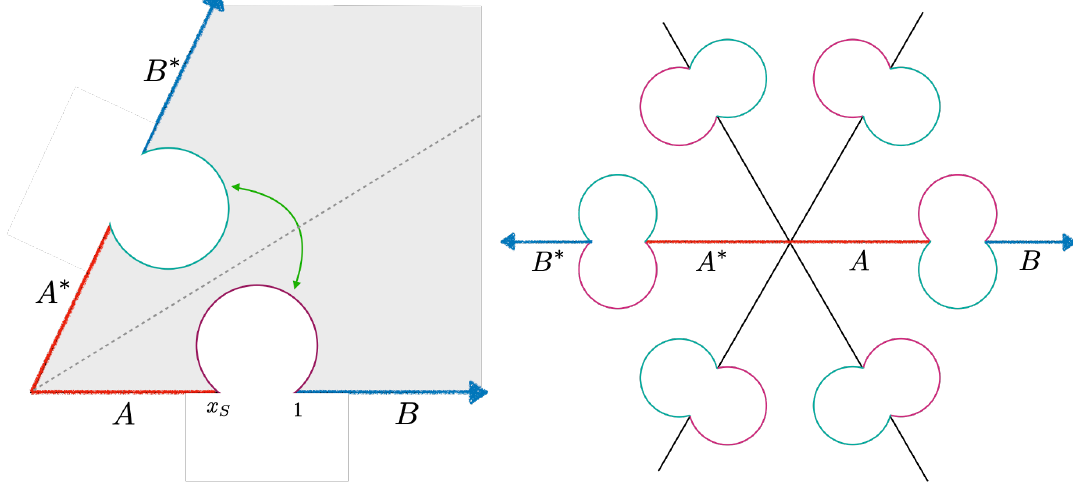
Figure 8 . (left) The Schottky domain (gray) of the first replica. The intervals A and B are mapped to [0 , x S ] and [1 , ∞ ] . The dual intervals A ∗ and B ∗ are mapped to [0 , e 2 πi/n x S ] and [ e 2 πi/n , ∞ ] . x S . Its exact form does not is a complicated function of the conformal cross-ratio x = ( a 1 − b 1 )( a 2 − b 2 ) ( a 1 − a 2 )( b 1 − b 2 ) matter to us as we only need the fact that x S → x when n → 1 . The two identifying circular arcs corresponds to the complementary segments A ∪ B in the original replica. The angle between the arcs and the radial axes is π/n . (right) The full Schottky domain of n = 6 , produced by replicating the single Schottky domain 6 times and glue accordingly. Two adjacent arcs of different colors are identified in the same way.